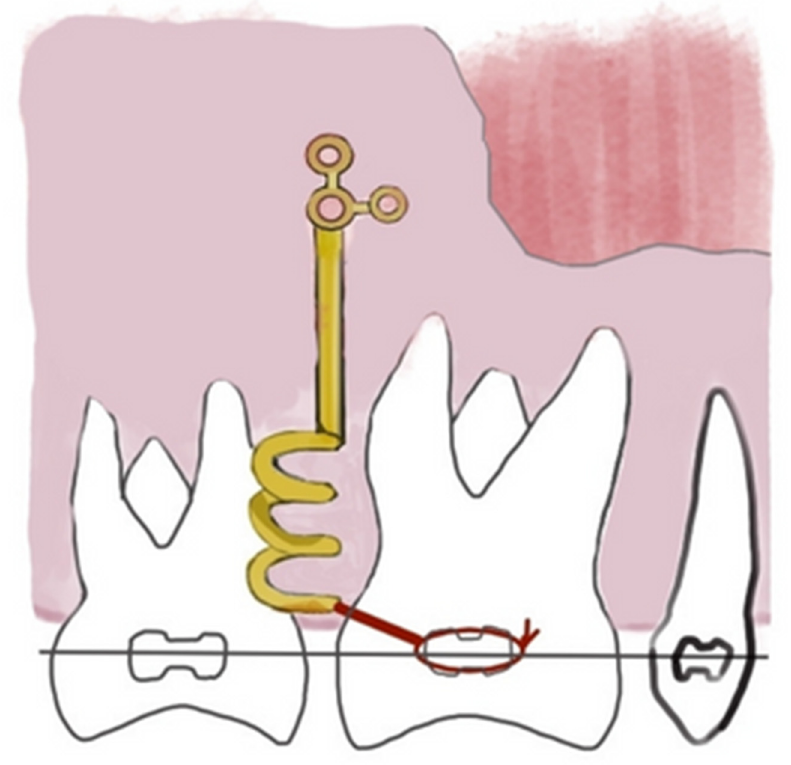
Figure 1. Orthodontic miniscrews (OMs) are anchorage devices in orthodontic